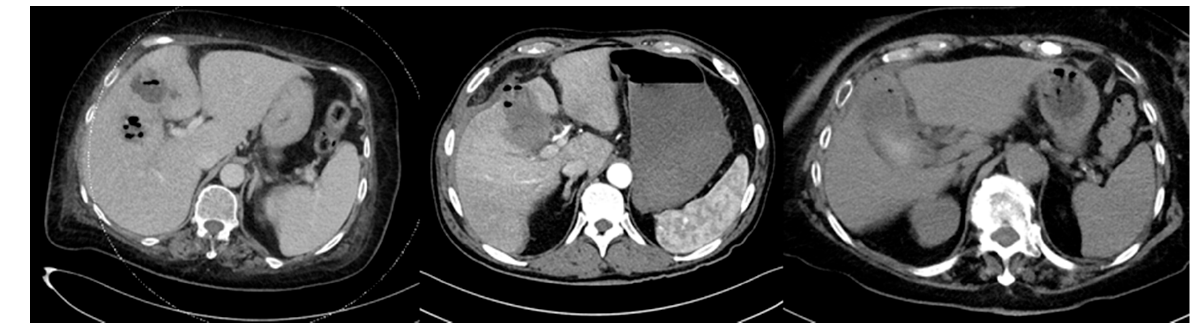
inside an adjacent liver abscess (far